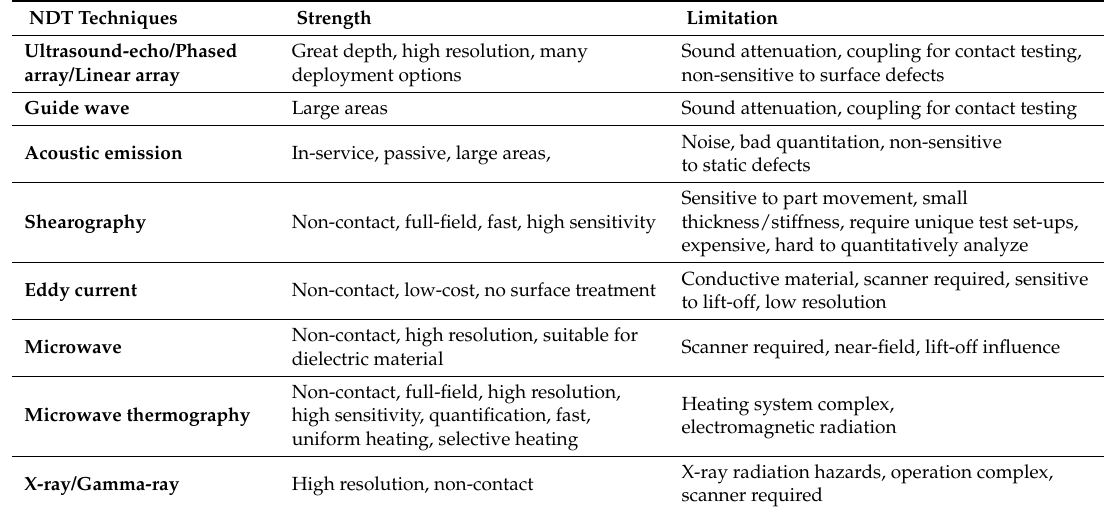
Table 4. Summary and comparison for MWT with major NDT